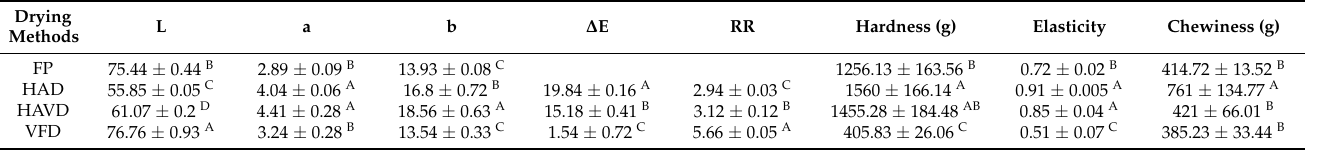
Table 1. Color parameters (lightness, redness or greenness, and yellowness or blueness), rehydration ratio and texture (hardness, elasticity, chewiness) of L. decastes treated by different drying